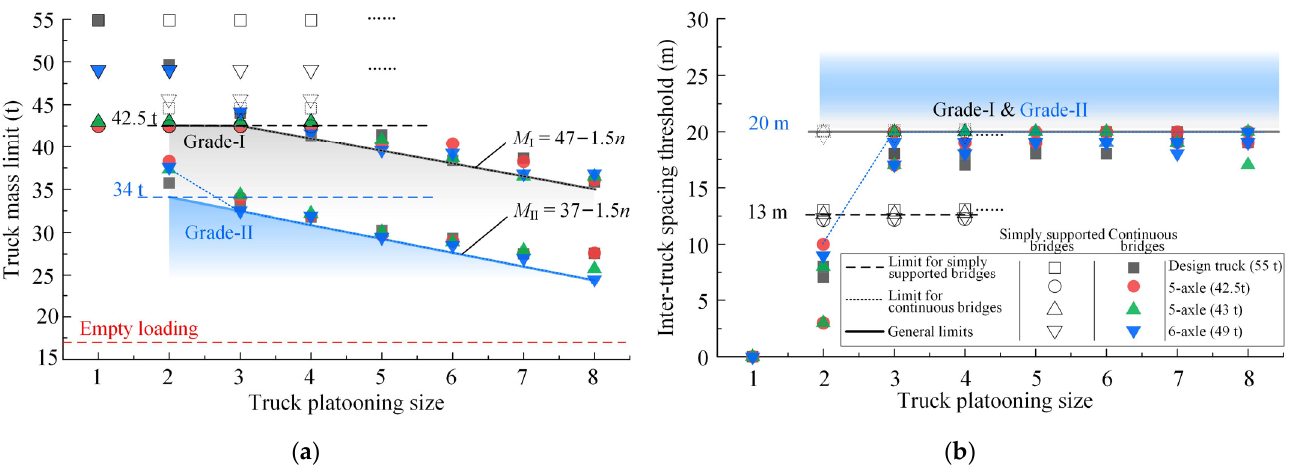
Figure 14. Identification of the general upper mass limits for platooning trucks crossing highway bridges with the standard inter-truck spacing of 20 m. ( a ) the general upper mass limits for platooning trucks with a standard inter-truck spacing of 20 m; ( b ) the corresponding limits on the inter-truck spacings.